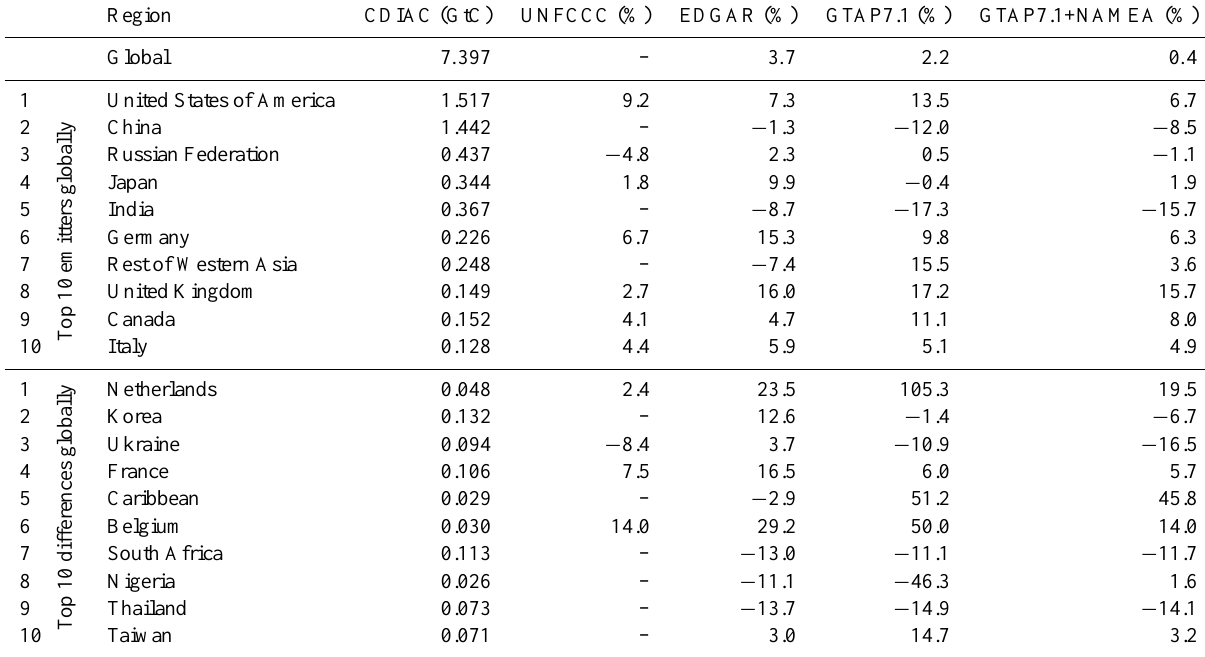
Table 3. Estimates of territorial-based carbon emissions (2004) from fossil fuel combustion and, in some cases, process emissions from different data sources. The first column shows the total emissions from CDIAC, and the other columns are percentage comparisons with CDIAC (positive is greater than CDIAC). The characteristics of each dataset are shown in Table 2. The CDIAC global total here does not include bunker fuels as we take the sum of the country totals excluding bunkers fuels. The “Top 10 differences globally” are sorted by the range in estimates; maximum minus